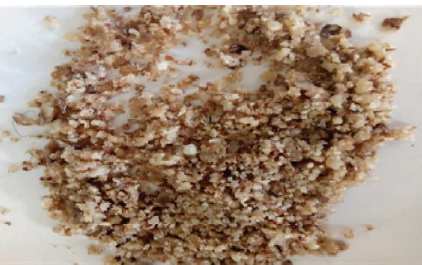
Figure 3: Pounded sample of Sclerocarya birrea seed